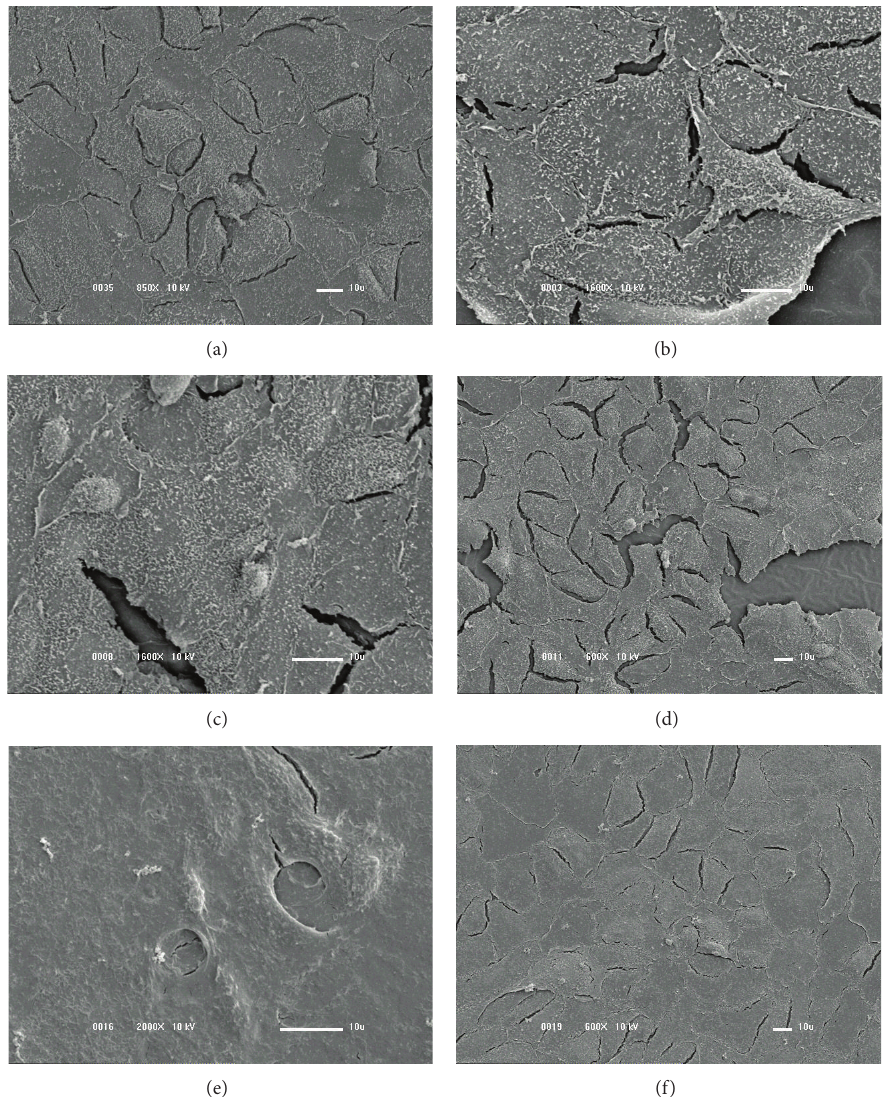
Figure 9: SEM surface images of the PVC samples after 48 hours of cellular cultivation. (a) Nontreated PVC plate. Sample covered with films = 5.3 %, (c) P = 28.9 %, (d) P = 44.7 %, (e) P = 55.3 %, and (f) P = 65.8 prepared with (b) P Ar Ar Ar Ar Ar